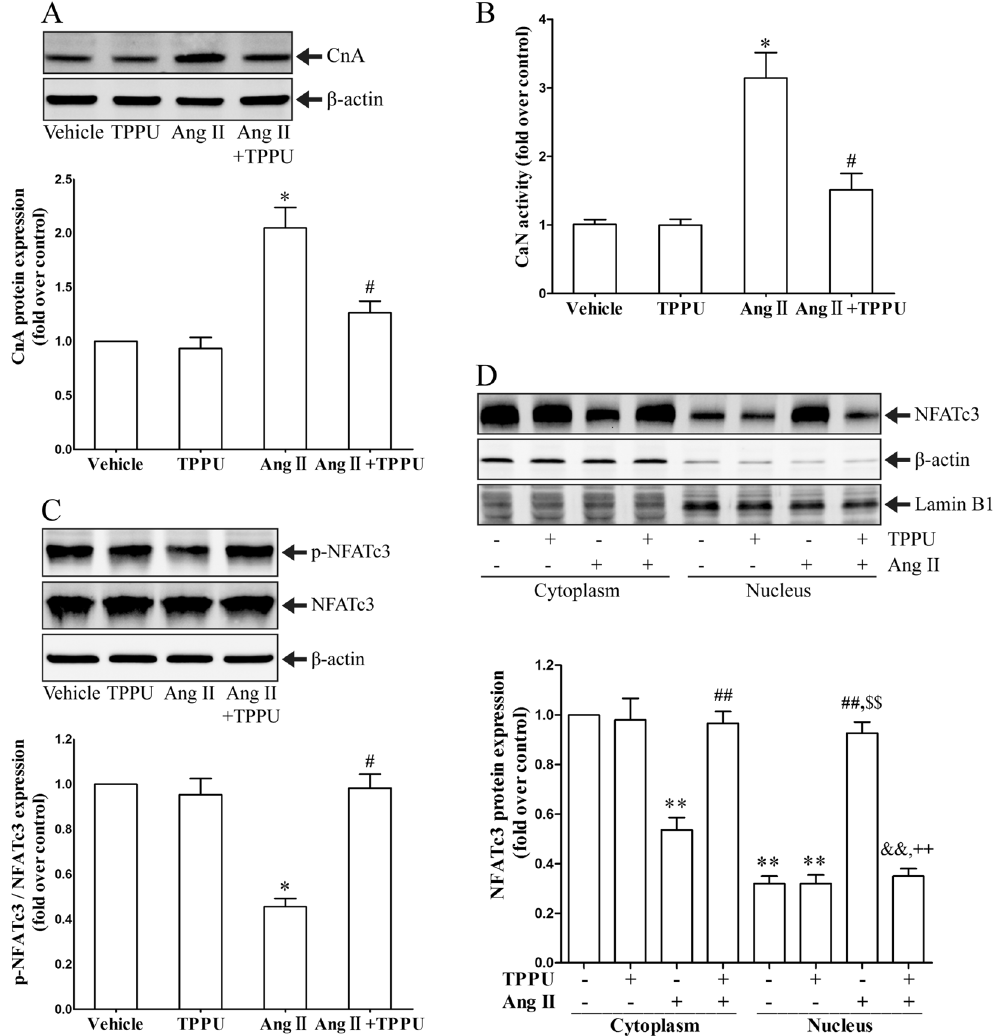
Figure 3. TPPU administration regulated Calcineurin/NFATc3 signaling in adventitial remodeling mice. ( A ) Representative immunoblots and quantitation of CnA protein expression in aortas. ( B ) Measurement of CaN phosphatase activity in aortas. ( C ) Representative immunoblots and quantitation of p-NFATc3/NFATc3 expression in aortas. ( D ) Representative immunoblots and quantitation of NFATc3 nuclear translocation in aortas. Data were expressed as Mean ± SEM, n = 8 mice for each group. * p < 0.05 vs. Vehicle, # p < 0.05 vs. Ang II, ** p < 0.05 vs. Vehicle (Cytoplasm), ## p < 0.05 vs. Ang II (Cytoplasm), && p < 0.05 vs. Ang II + TPPU (Cytoplasm), $$ p < 0.05 vs. Vehicle (Nucleus), ++ p < 0.05 vs. Ang II